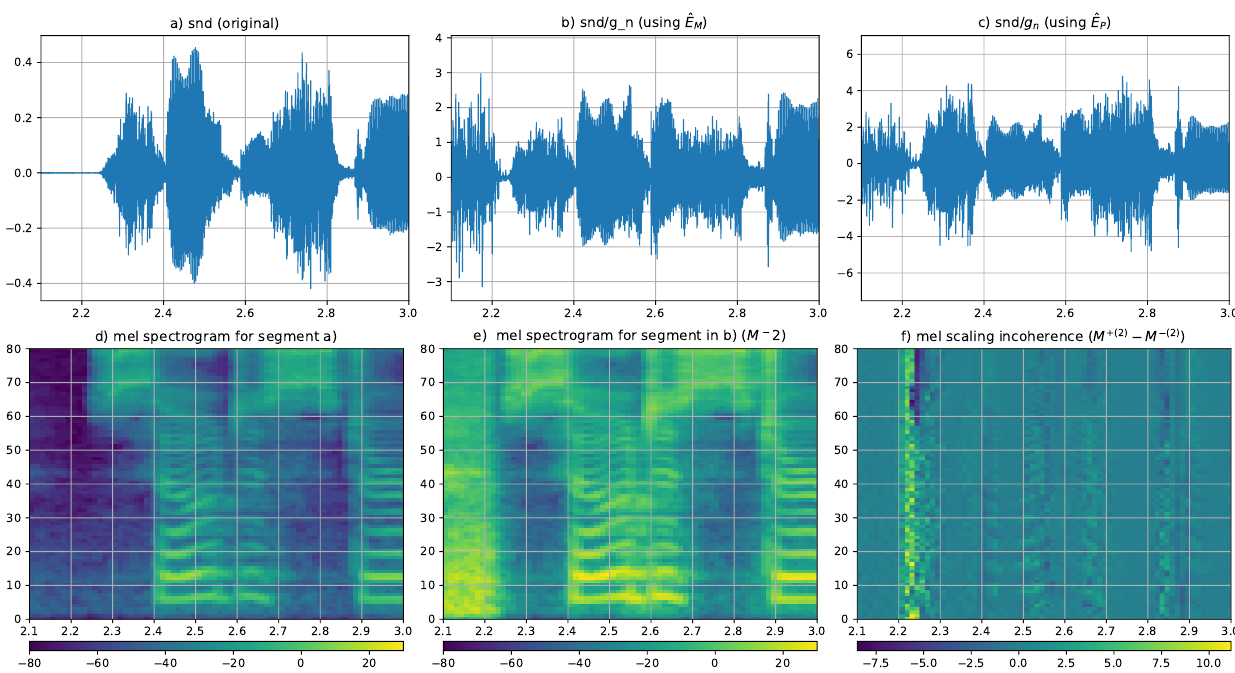
Figure 3. Adaptive normalization applied to a short segment of a speech signal. ( a ) Short seg- ment of original speech signal. ( b ) Signal after normalization using g Equation (17) (note the change in vertical axis limits). ( c ) The same as in ( b ) but using energy estima- tion from Equation (16). ( d ) Mel spectrogram of original sound for the segment displayed in ( a ). ( e ) Mel spectrogram M − ( 2 ) of sound segment in ( b ). ( f ) Visualization of the incoherence as the difference between the mel spectrogram from ( e ) and the mel spectrogram M +( 2 ) obtained by means of shifting mel frames in ( d